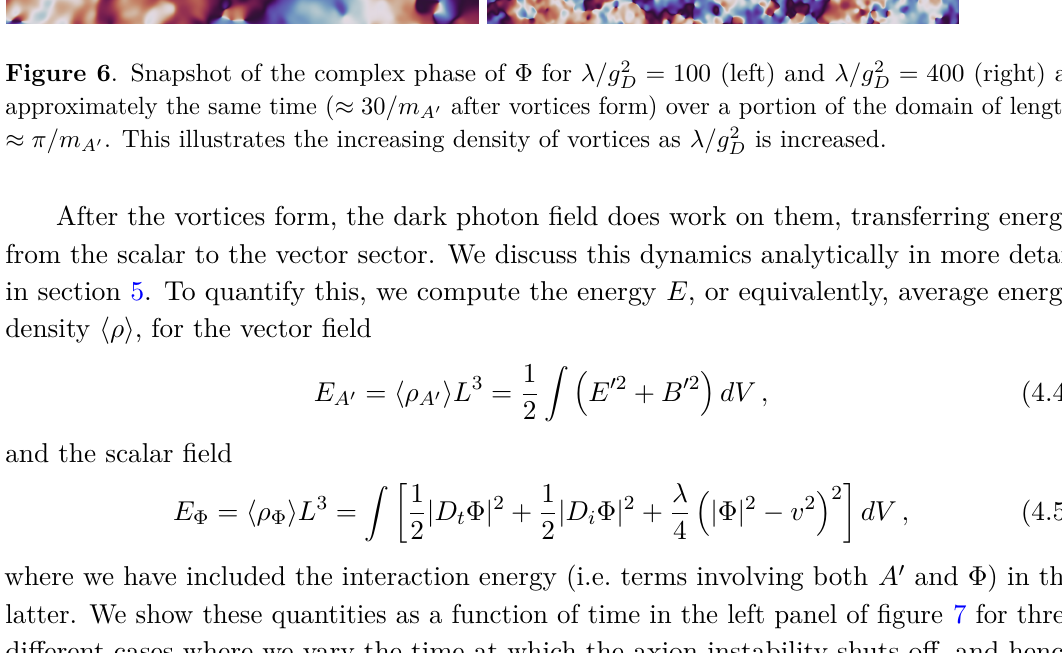
Figure 6 . Snapshot of the complex phase of Φ for λ/g 2 approximately the same time ( ≈ 30 /m A 0 after vortices form) over a portion of the domain of length ≈ π/m A 0 . This illustrates the increasing density of vortices as λ/g 2